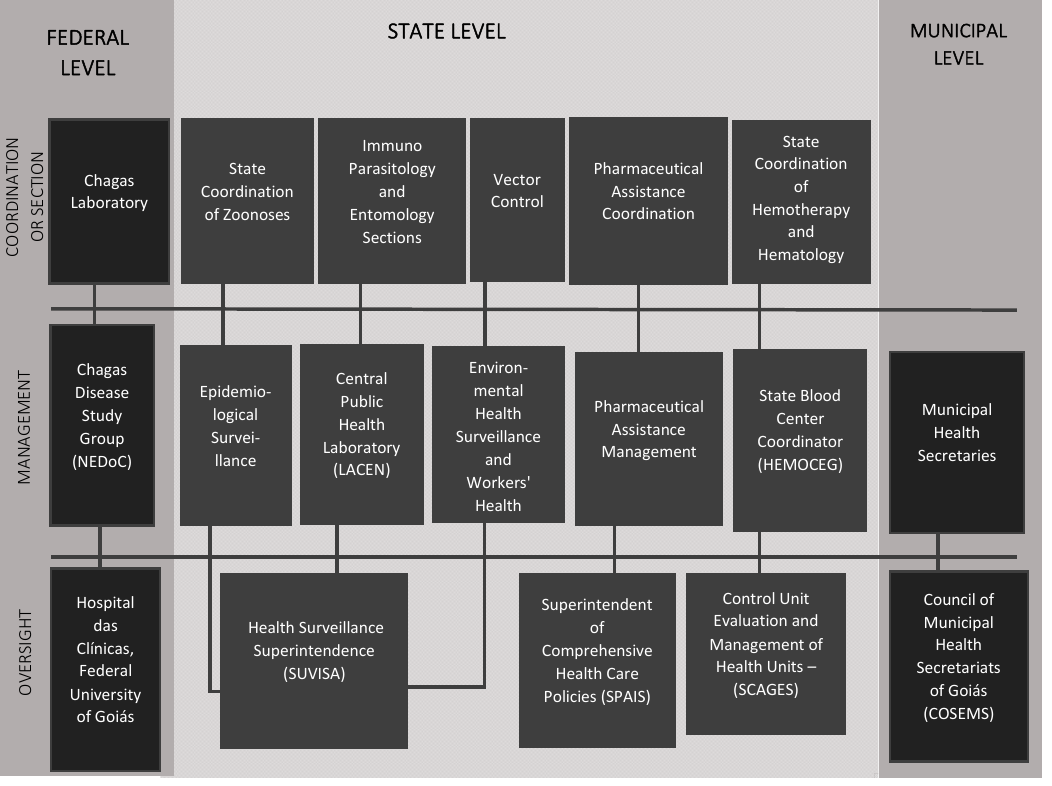
Figure 2. Main actors involved in the initiative to create the notification policy for chronic Chagas Figure2. disease.